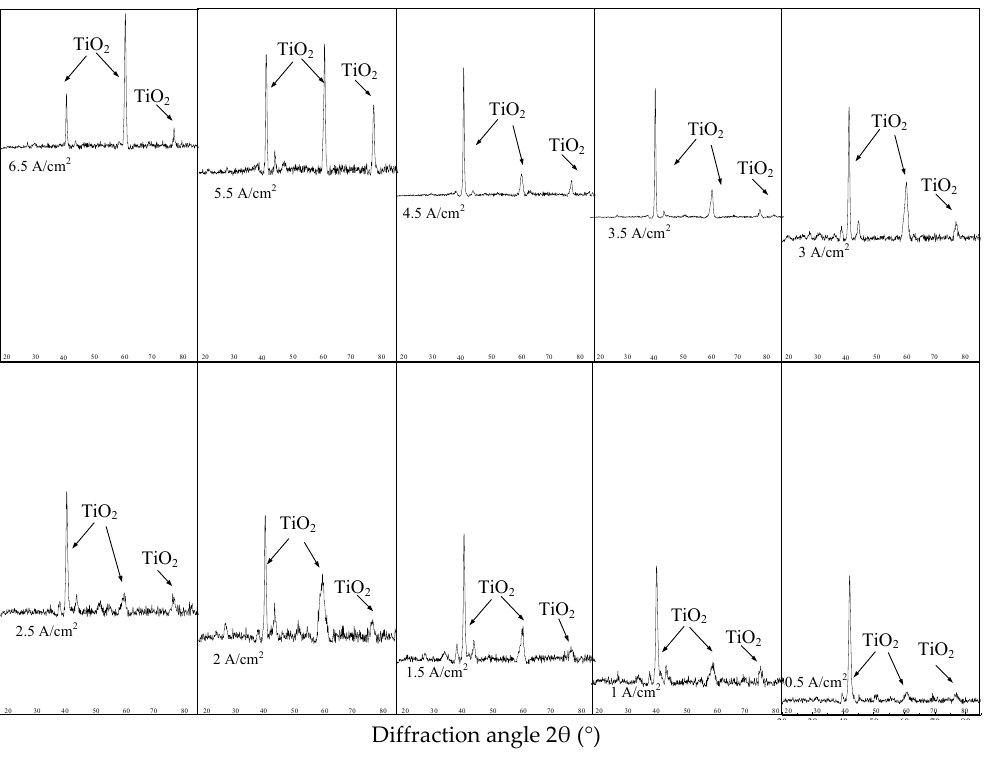
Figure 4. XRD patterns of electrochemical polishing surface.